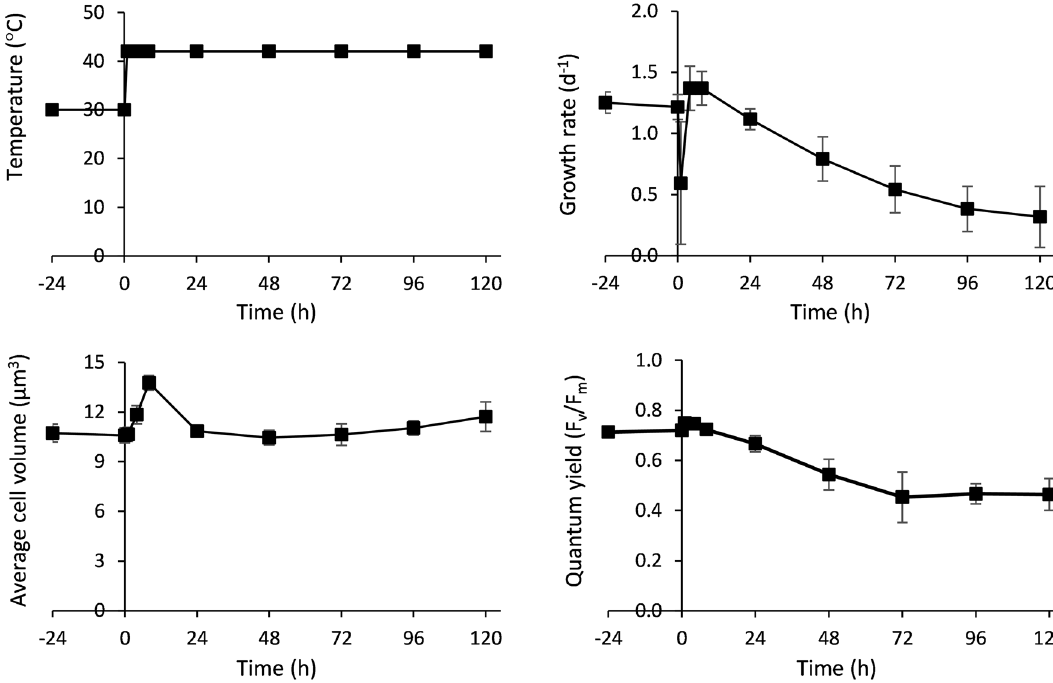
Figure 1. Effect of temperature increase to supra-optimal value, on the specific growth rate (d −1 ), quantum yield (F v /F m ), and average cell volume (μm 3 cell −1 ) in Picochlorum sp. (BPE23). Temperature was increased from steady state growth at 30–42 °C at Time = 0 h. Data represents the mean ± standard deviation of biological triplicate